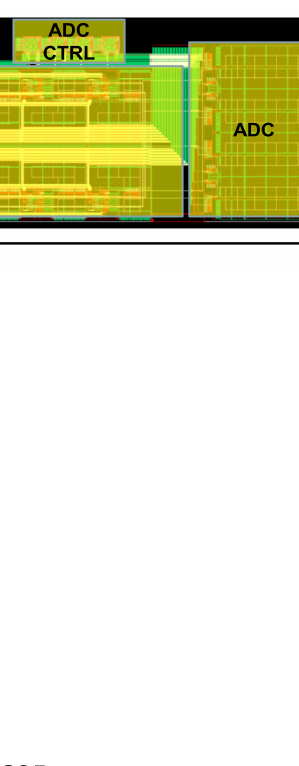
Figure 10. Die Photograph in a 180 nm CMOS Process.